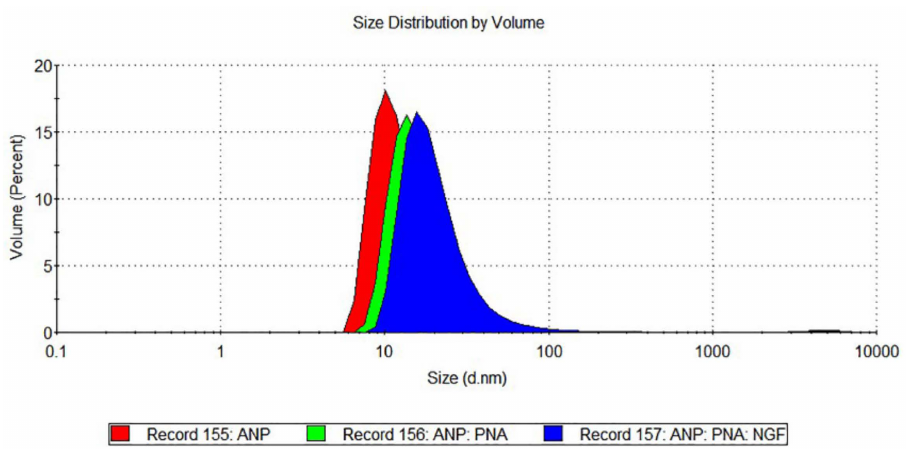
Figure 1. Nanoparticle characterisation through dynamic light scattering measurements. The hydro- dynamic diameter increase of single- (ANP:PNA, green curve) and double- (ANP:PNA:NGF, blue curve) functionalised polyacrylamide nanoparticles resulted in a shift of size distribution compared to naked ANPs (red